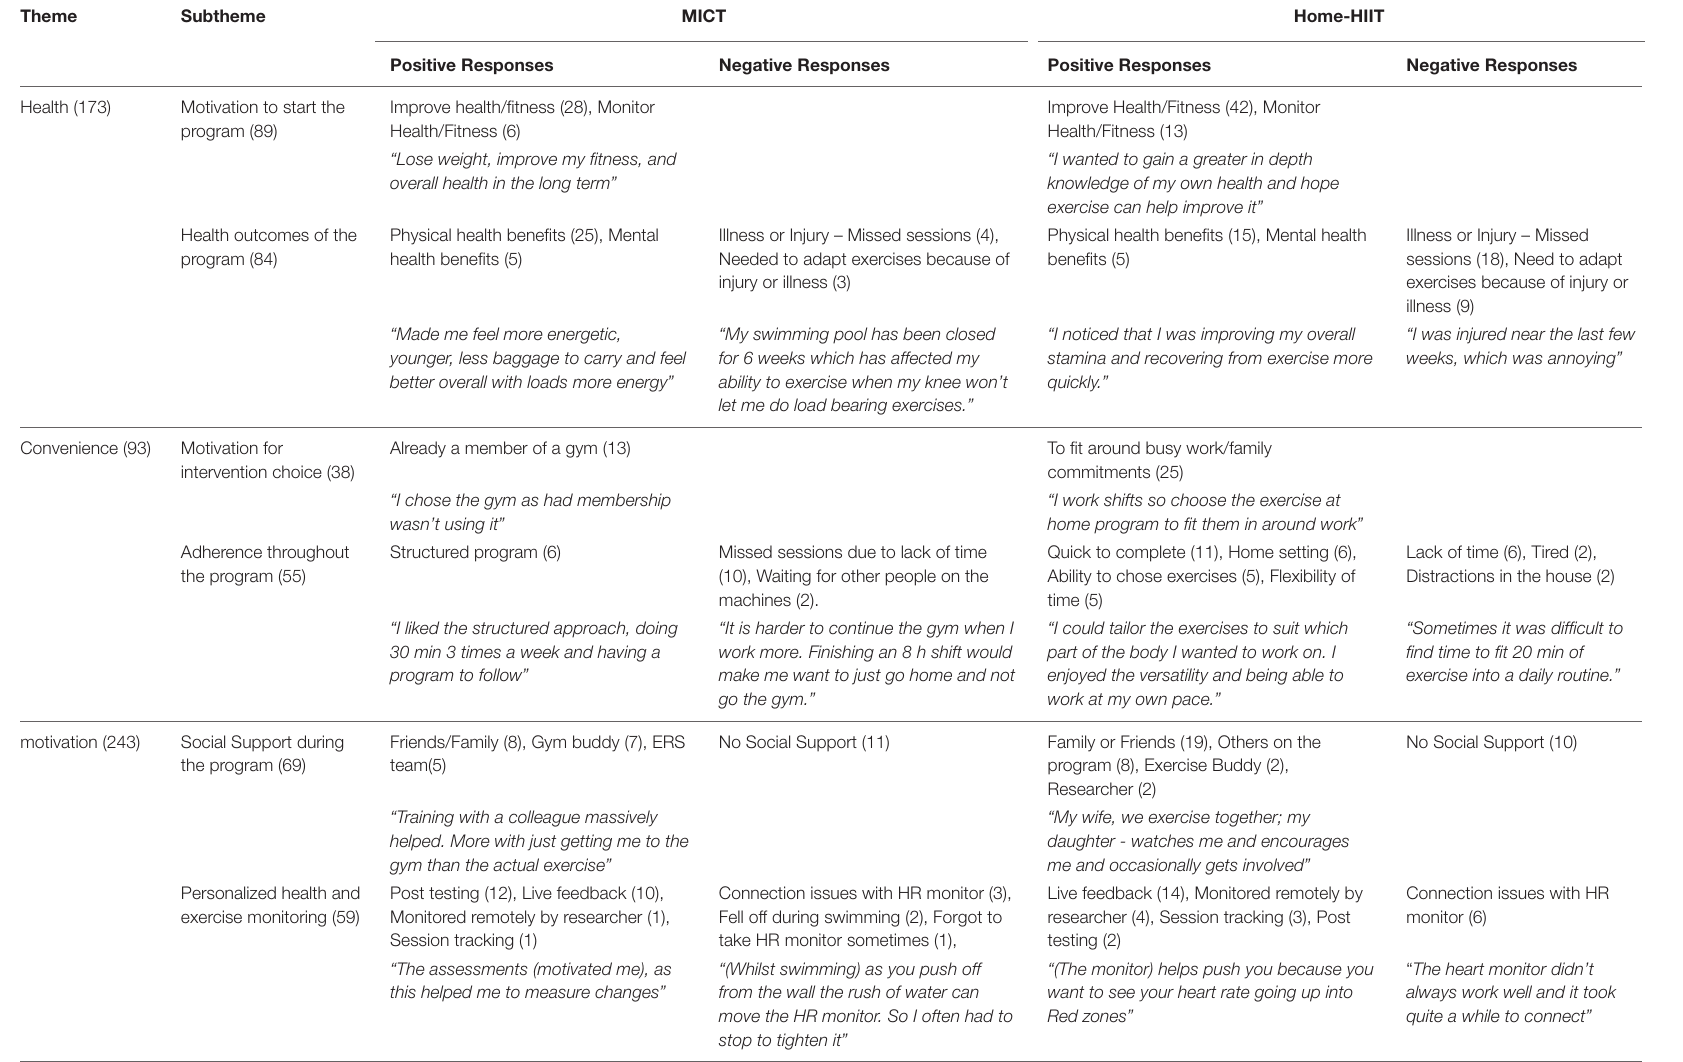
TABLE 8 | Summary of participant responses in qualitative survey.